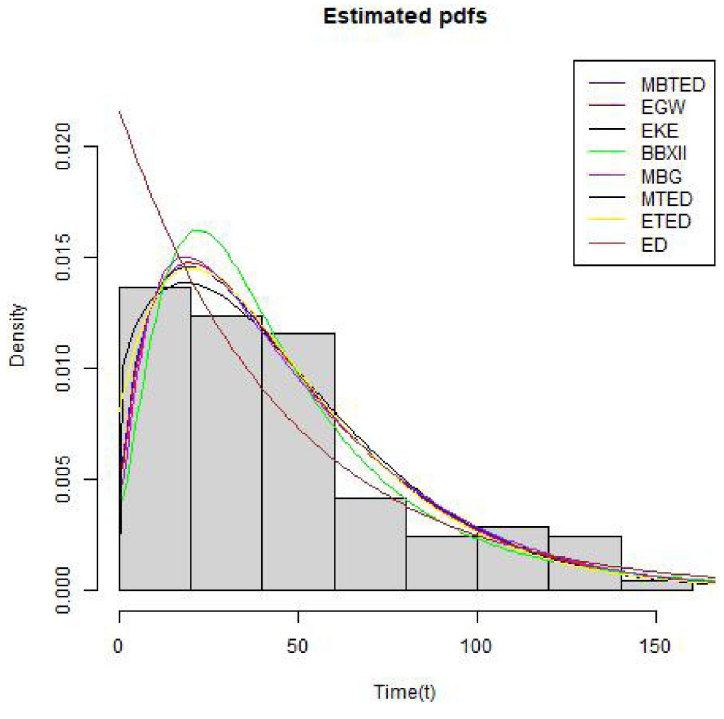
Fig 8. Estimated pdf plots.